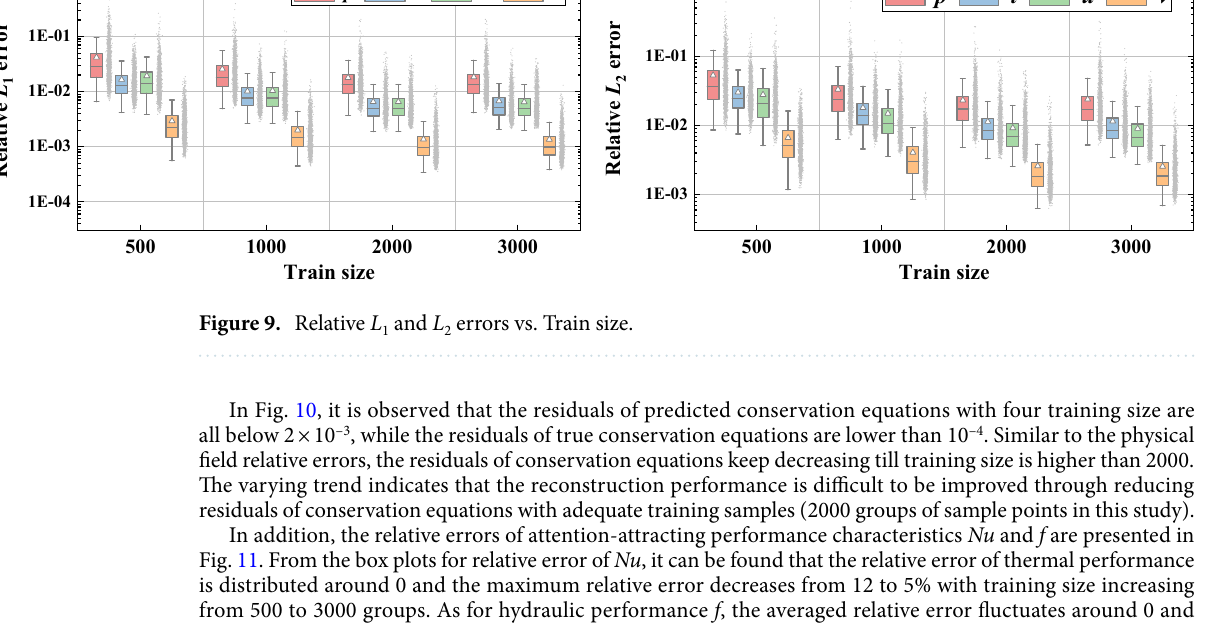
from 500 to 3000 groups. As for hydraulic performance f , the averaged relative error fluctuates around 0 and